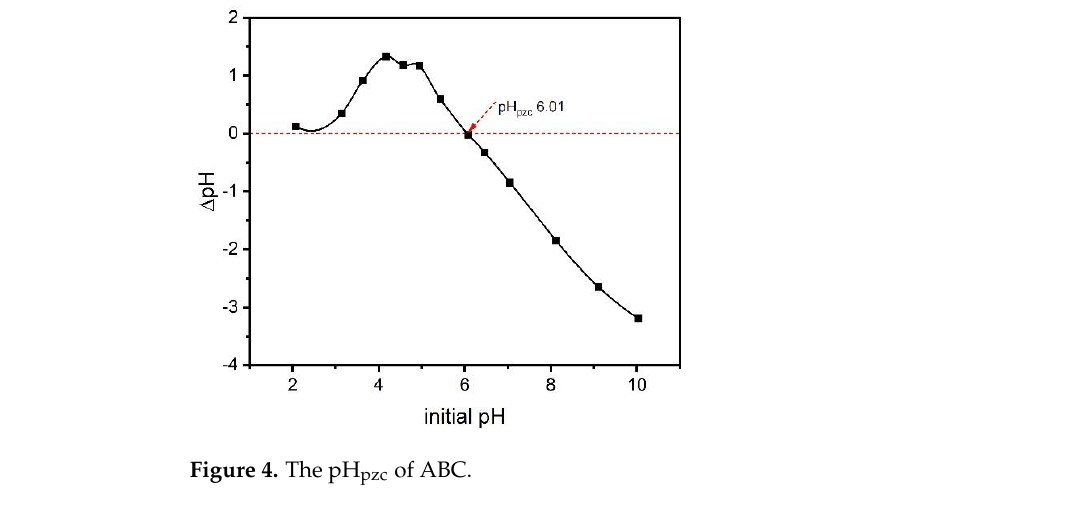
Figure 4. The pH pzc of ABC.